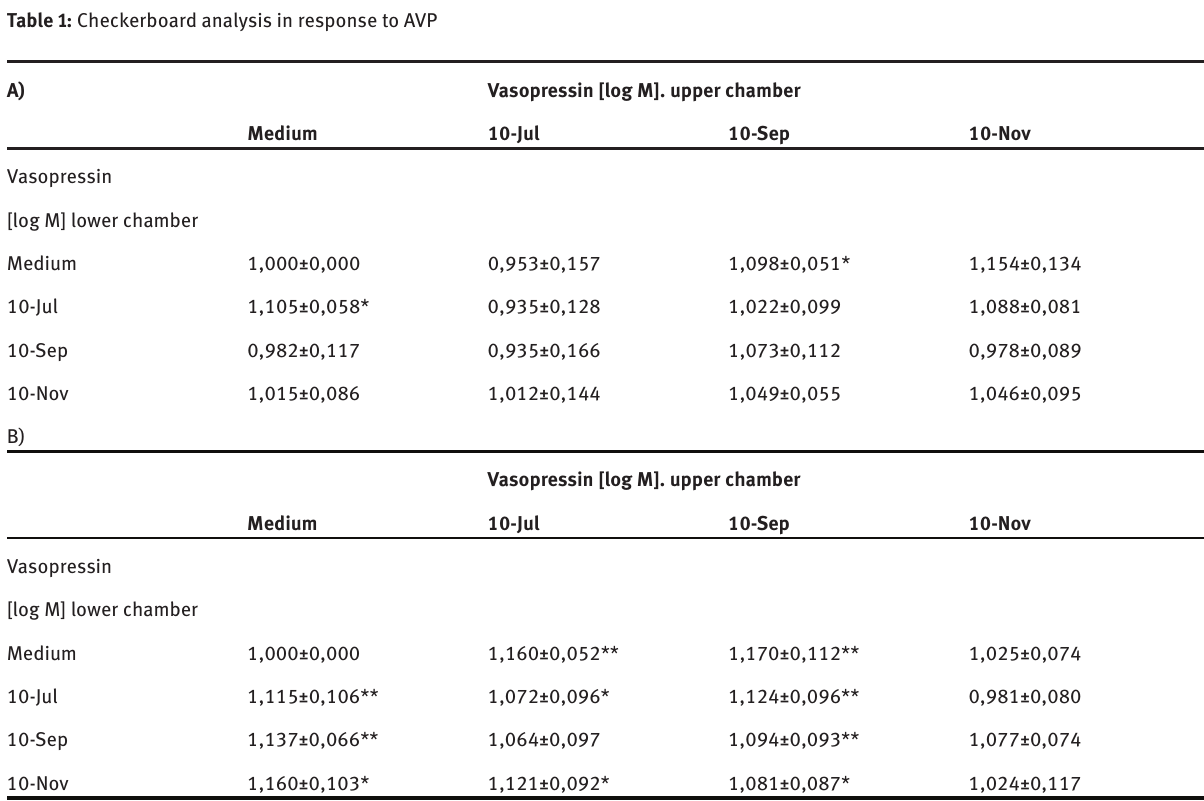
PMNs (A) and monocytes (B) migrated in response to different concentrations of AVP. The upper wells were filled with cells supplemented with various concentrations of AVP. The lower wells were filled with medium (control), or different concentrations of AVP. Statistical analyses: Mann-Whitney U test [n.s., not significant, *, p<0.05, **,